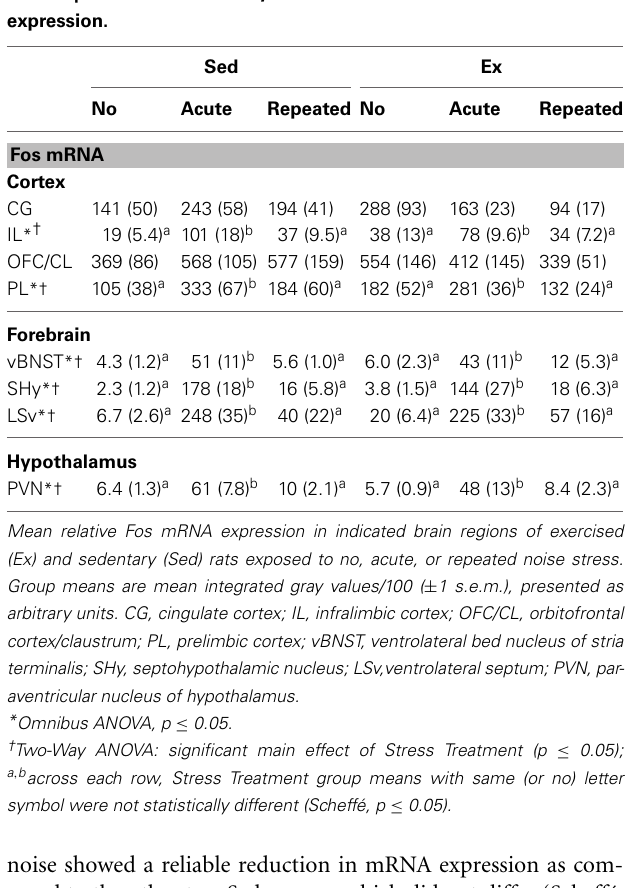
Table 2 | Effects of stress and wheel running on central CRH